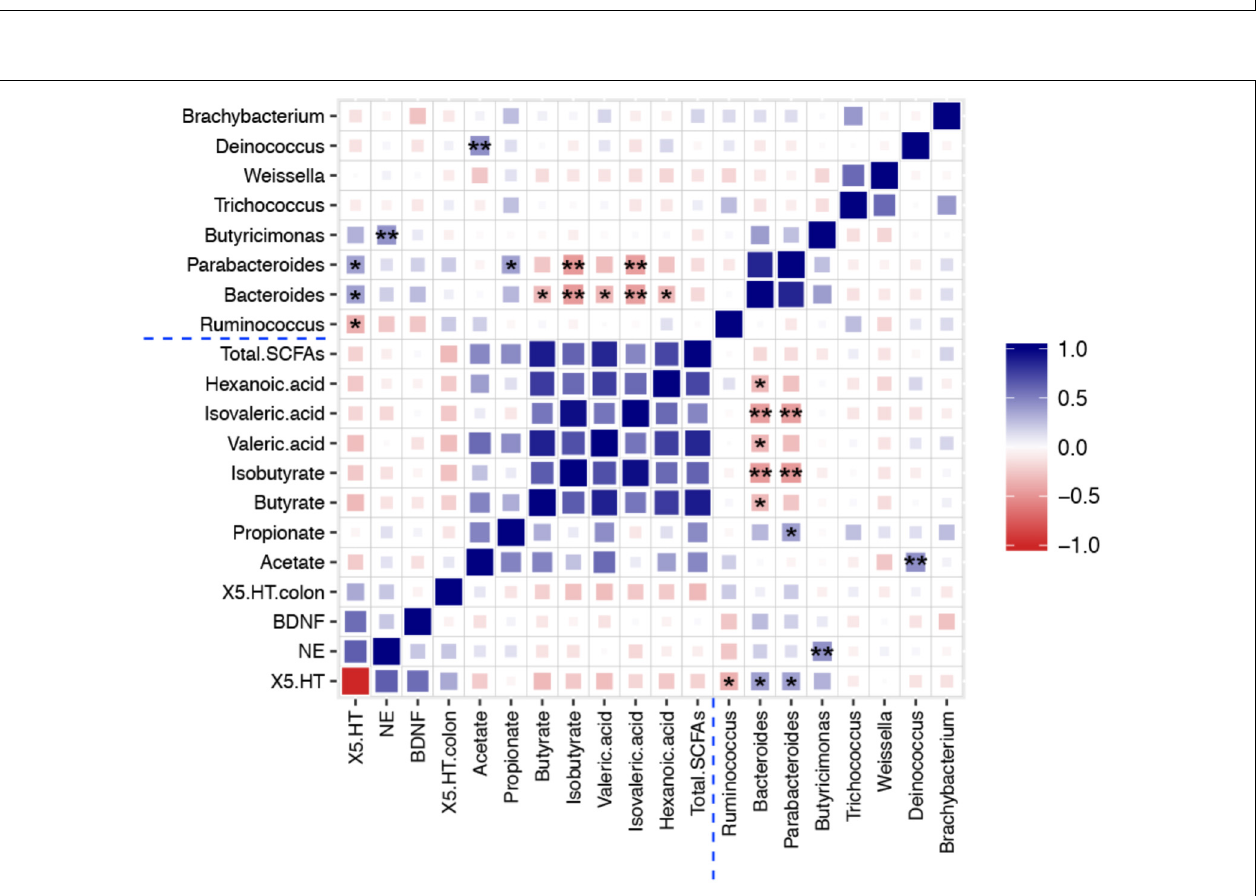
FIGURE 7 | Heat map summarizing the Pearson’s correlation between 5-HT, NE, and BDNF in hippocampus, 5-HT in colon, gut microbiota, and SCFAs. ∗ P < 0.05, ∗∗ P < 0.01.